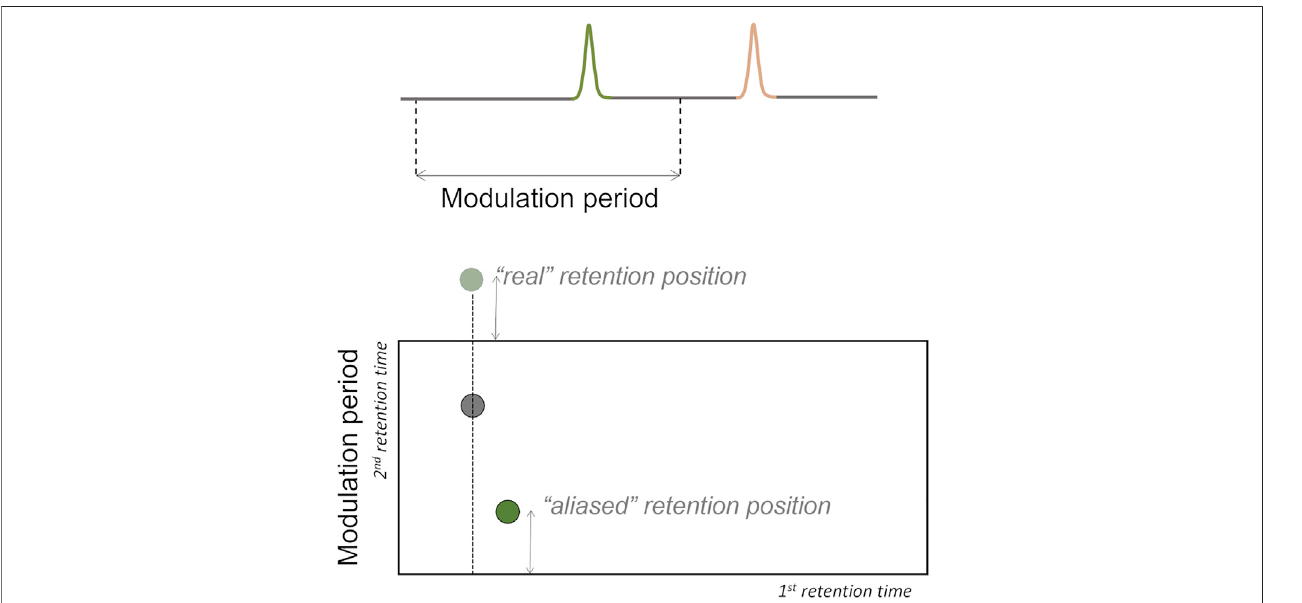
FIGURE 7 | Wrap-around phenomenon may occur if the separation on the 2nd dimension does not fi nish before the next modulation, i.e., the elution time of the analyte exceeds the modulation time.